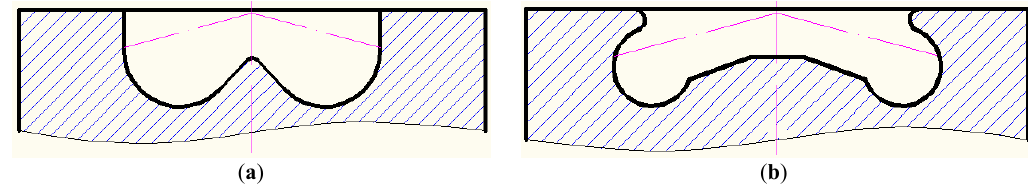
Figure 7. The prototype and modified combustion chamber. ( a ) The prototype piston head with straight ω chamber; ( b ) the modified piston head with reentrant chamber.